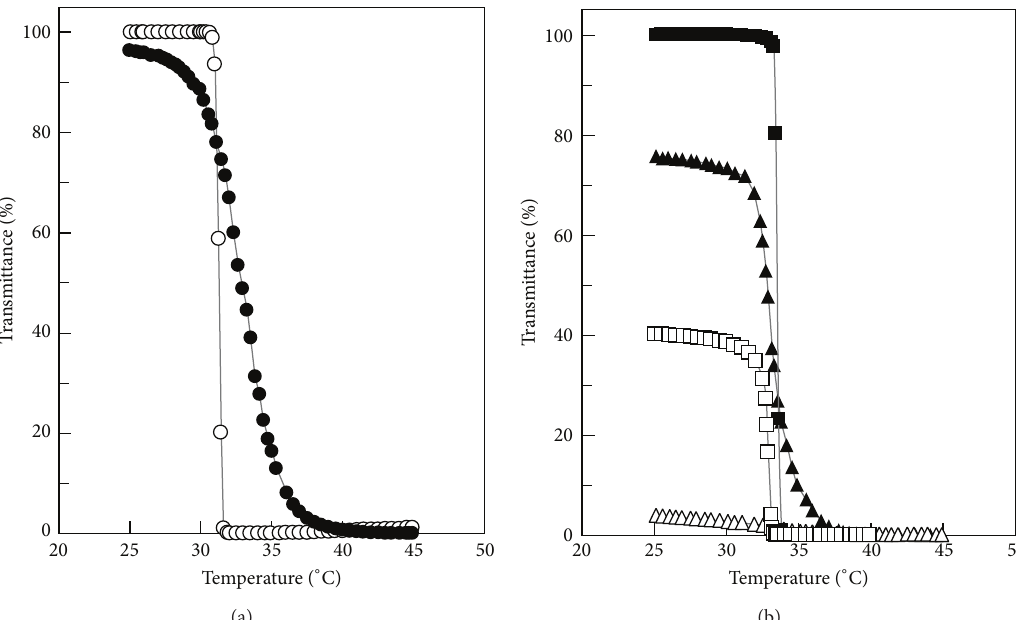
Figure 2: Temperature dependence of transmittance of 10mg/mL aqueous solutions of (a) poly(TEMPMA- ran -NIPAAm) ( 1 ) (solid circle), poly(TEMPOMA- ran -NIPAAm) ( 1 󸀠 ) (open circle); (b) PNIPAAm- block -PTEMPMA ( 2 ) (solid triangle) PNIPAAm- block -PTEMPOMA ( 2 󸀠 ) (open triangle); PNIPAAm- block -PTEMPOMA- block -PNIPAAm ( 3 ) (solid square) and PNIPAAm- block -PTEMPOMA- block -PNIPAAm ( 3 󸀠 ) (open